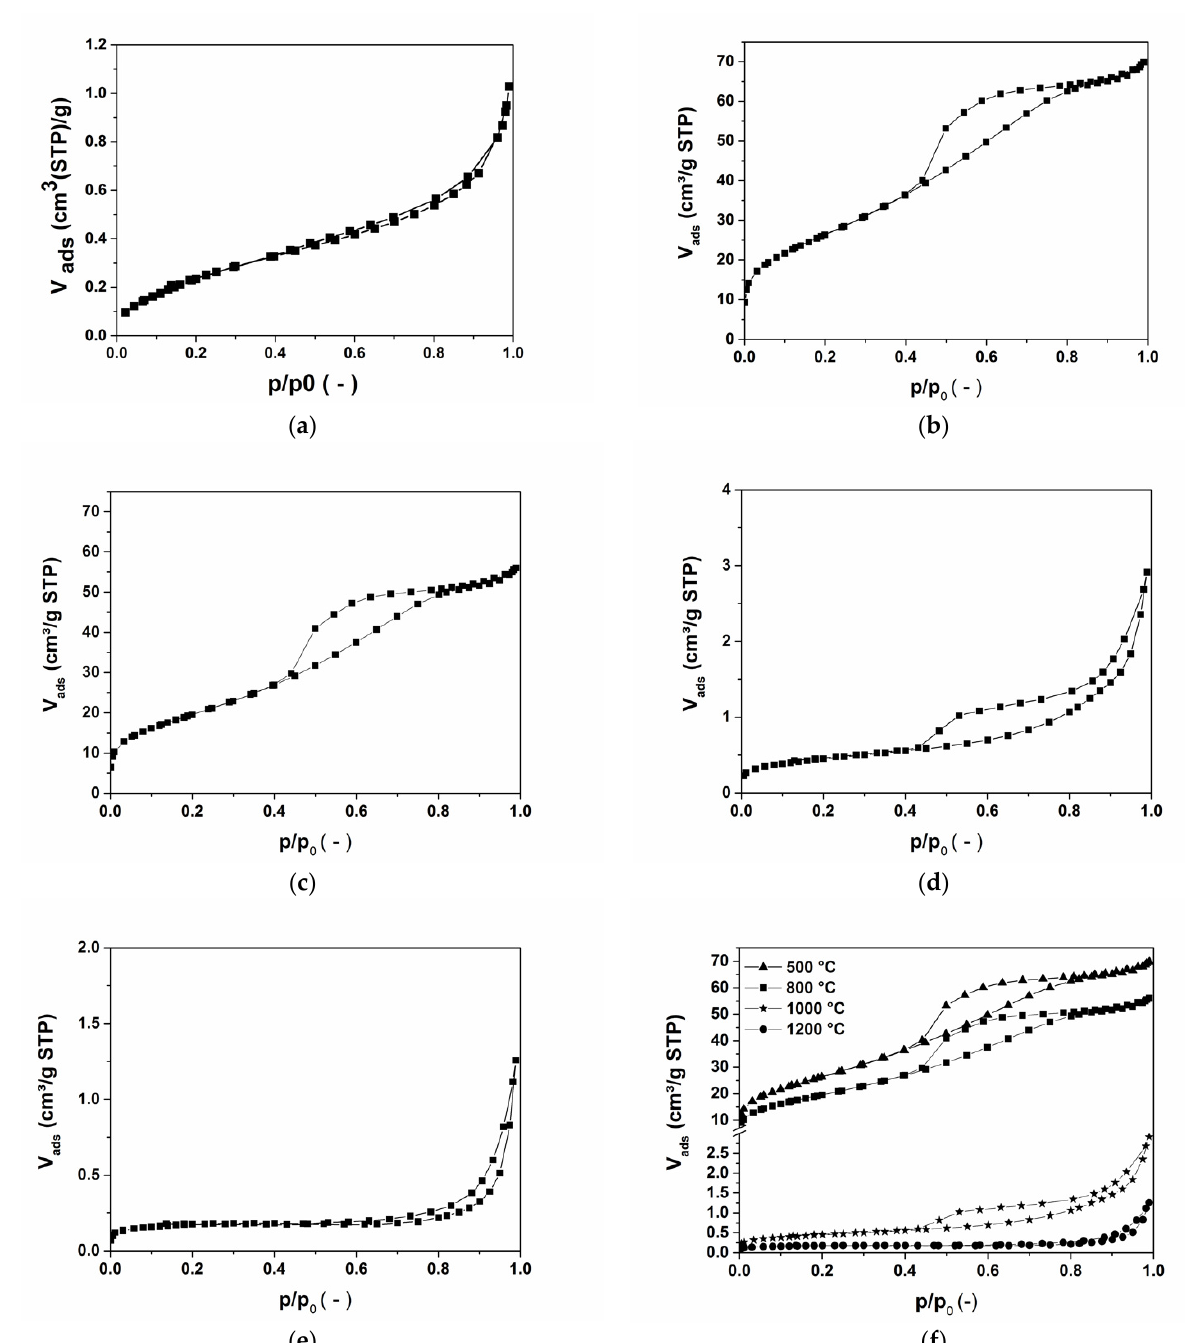
Figure 8. Adsorption − desorption isotherm of nitrogen for samples of gel at temperature 85–1200 ◦ C; ( a ) Gel dried at 85 ◦ C; ( b ) Gel dried at 500 ◦ C; ( c ) Gel calcined at 800 ◦ C; ( d ) Gel calcined at 1000 ◦ C; ( e ) Gel calcined at 1200 ◦ C; ( f ) Interrelation of measured